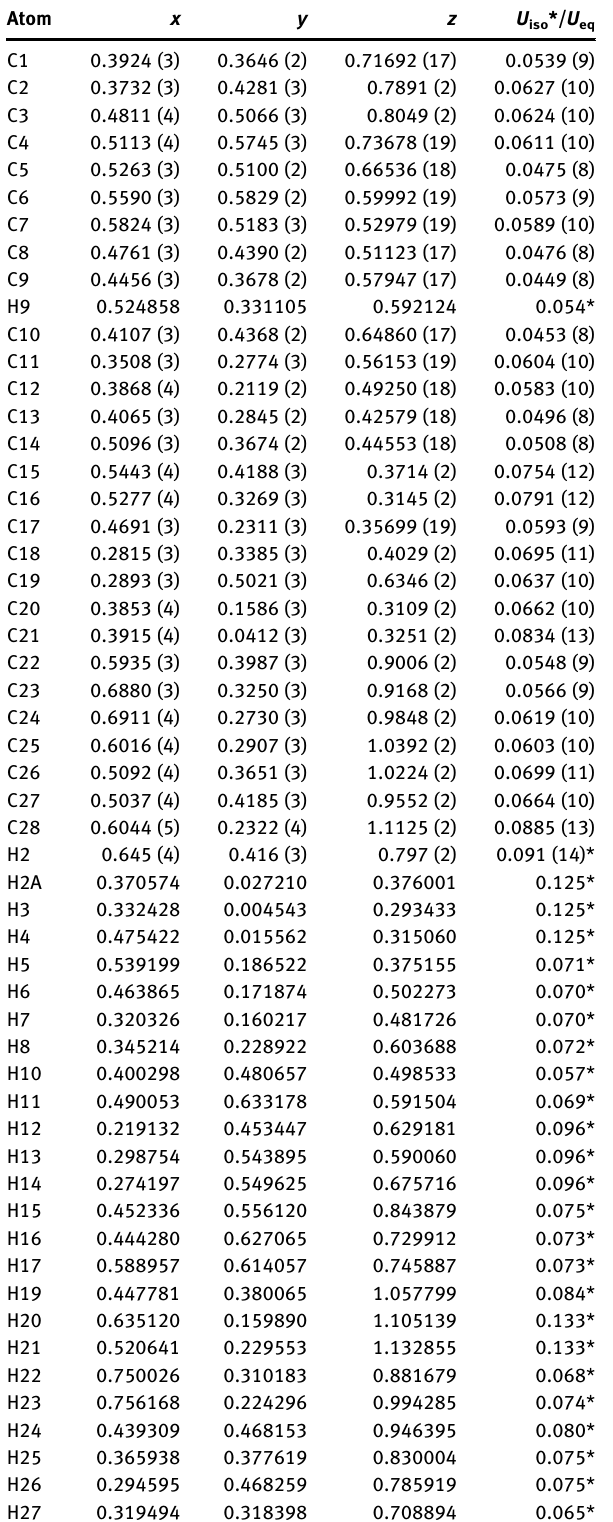
Table  : Fractional atomic coordinates and isotropic or equivalent isotropic displacement parameters (Å 